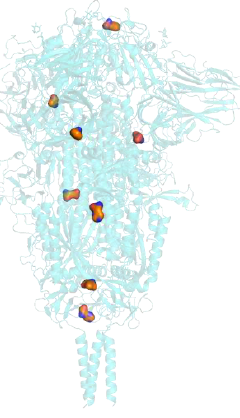
Figure 4. Spike structure of outstanding mutations of Spanish and British SARS-CoV-2 variants.